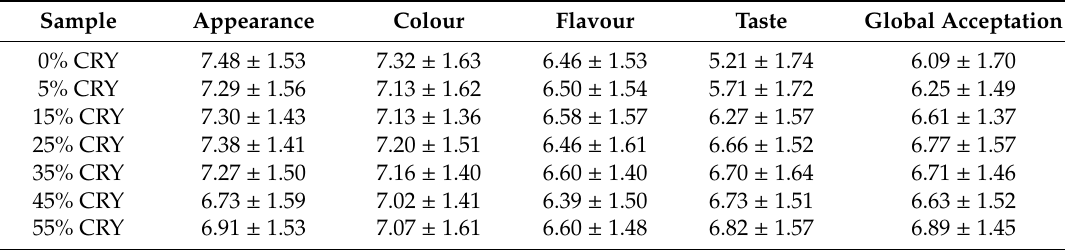
Table 1. Results of sensory evaluation averages.